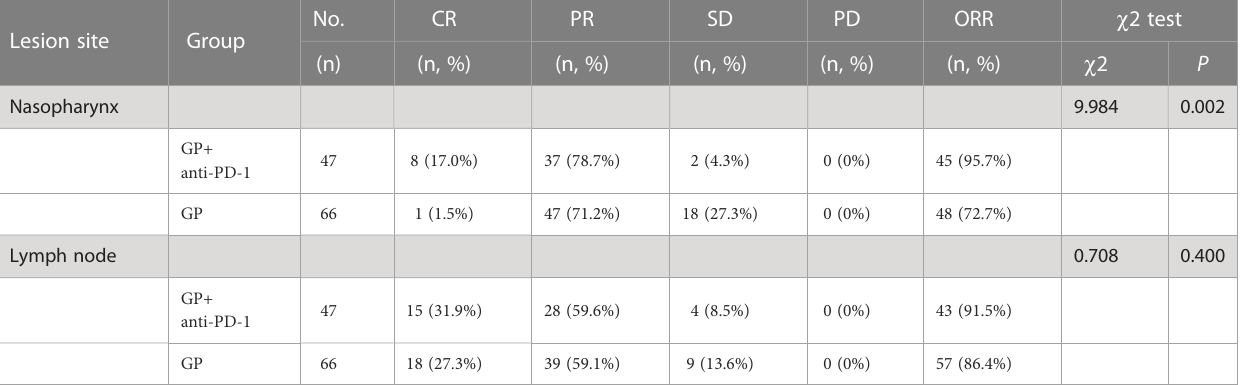
TABLE 3 Comparison of short-term ef fi cacy between GP and GP + anti-PD-1 group.